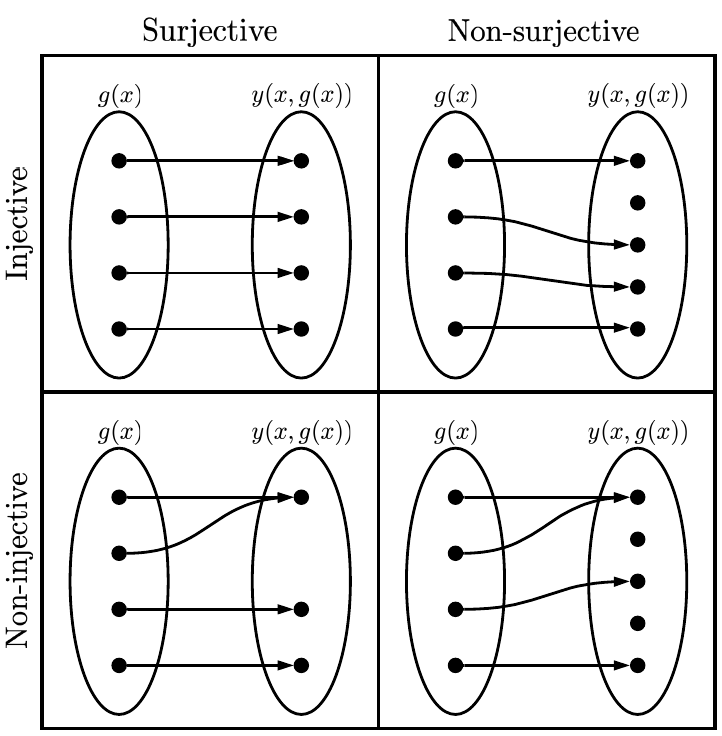
Figure 1. Graphical representation of injective and surjective